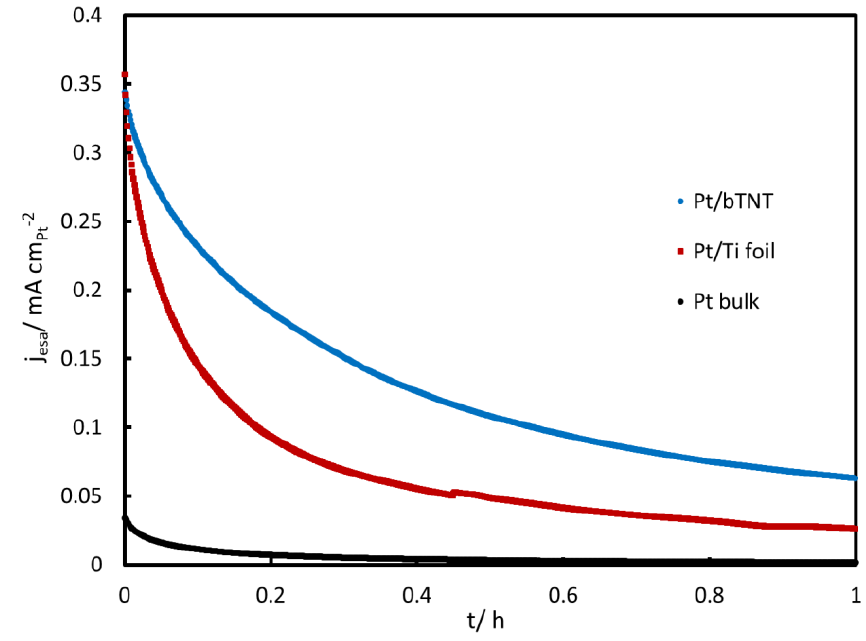
Figure 8. Chronoamperometric curves recorded at +0.4 V SCE during 1 h. The current is normalized per Pt electroactive area in cm 2 .